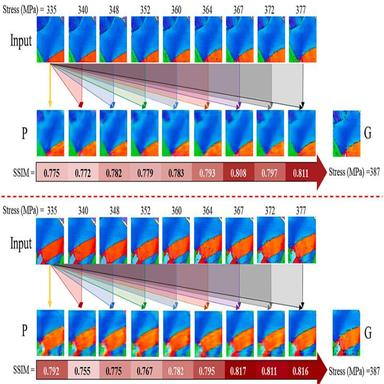
Examples of the 11th frame predicted by the model trained on different lengths of input sequence. G and P indicate ground truth and prediction. SSIM: structural similarity index measure.